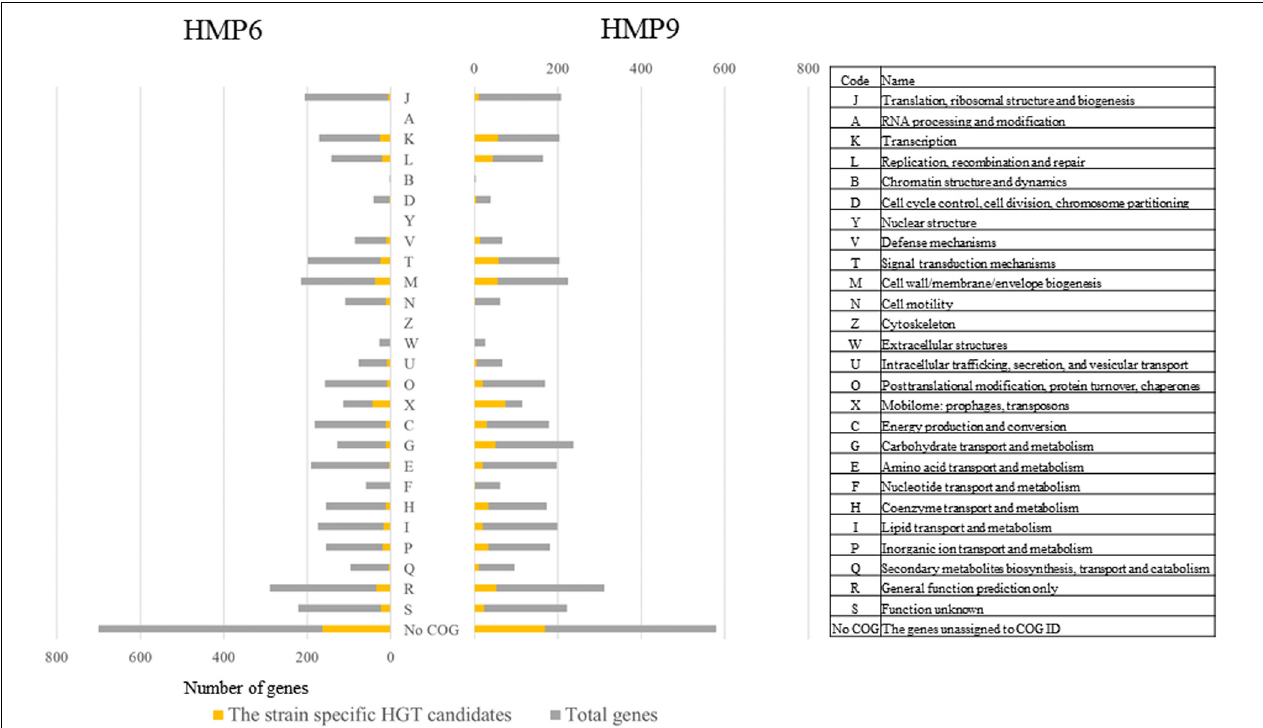
FIGURE 6 | Distribution of the detected genes in Antarctic HMP6 and HMP9 strains grouped according to their COG functional categories. The COG functional codes and detailed description of COG functional categories are presented in the right-side list. Gray ( (cid:4) ): total number of total genes; orange ( (cid:4) ): number of strain-specific HGT candidates.